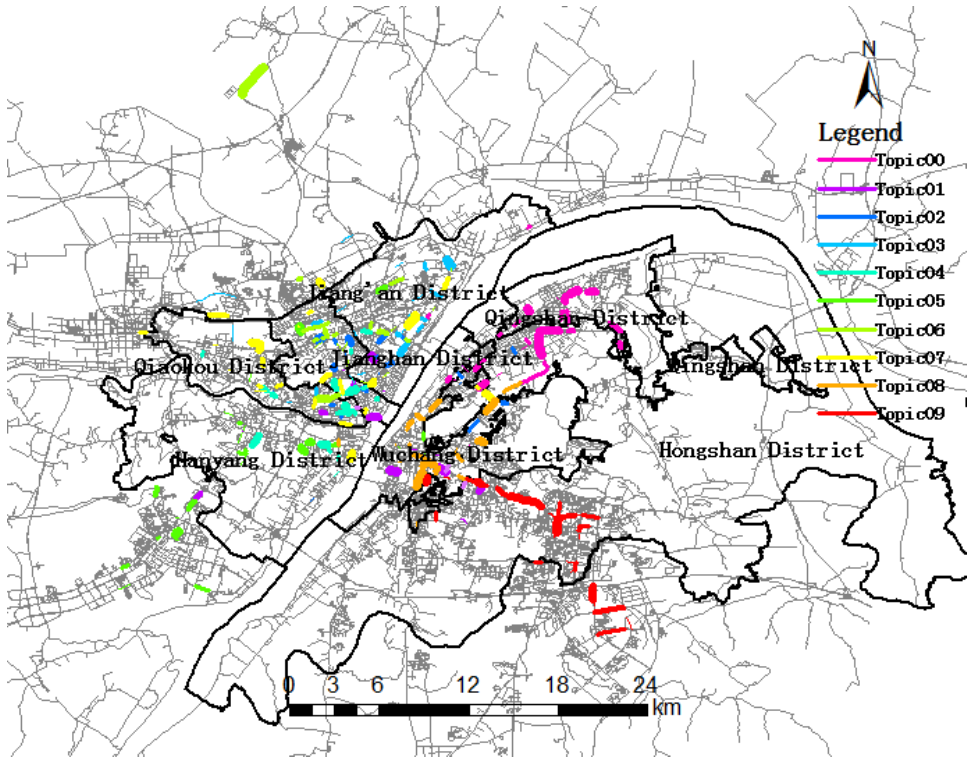
Figure 7. Ten topics during the morning rush hour period.